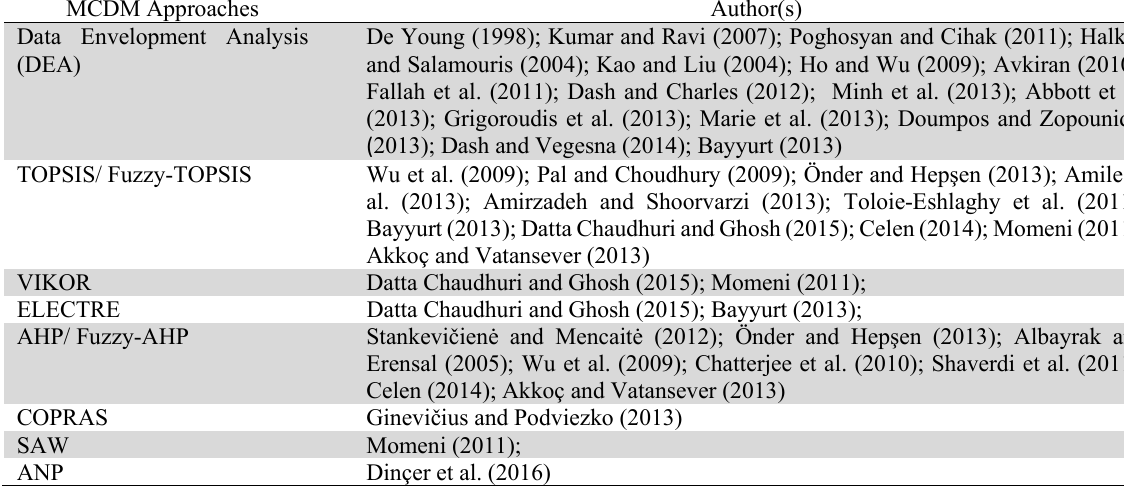
MCDM techniques used in evaluating bank